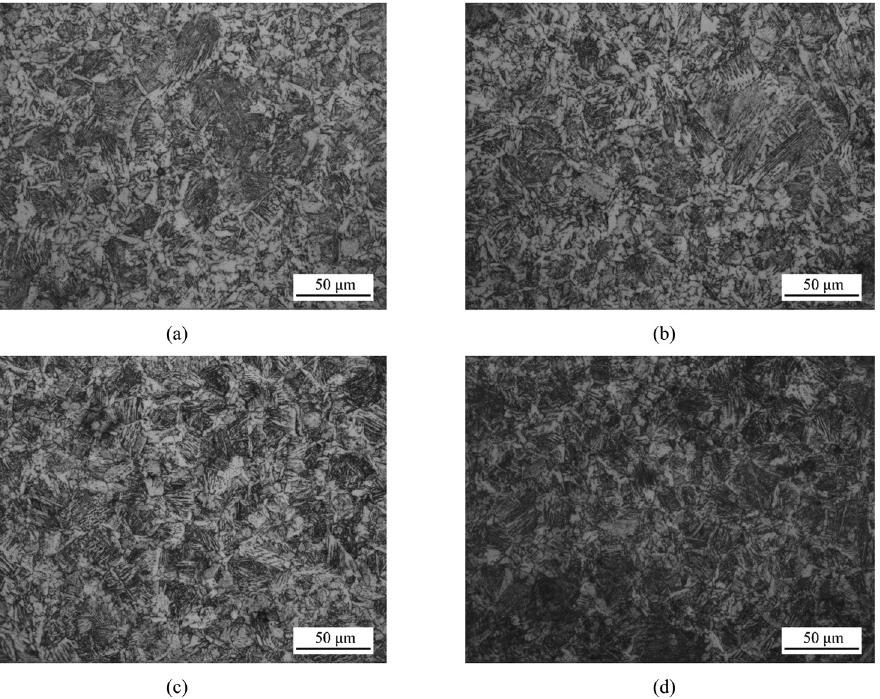
Figure 8: Microstructure of the specimens subjected to single quenching treatment at the austenitizing temperature of ( a ) 900°C, ( b ) 920°C, ( c ) 940°C and ( d )